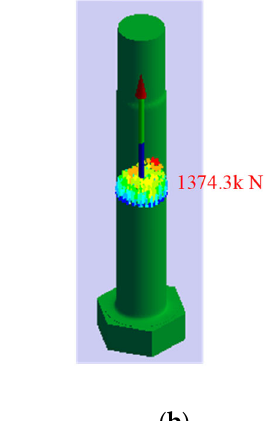
Figure 13. Resultant force of bolt: ( a ) existing configuration and ( b ) new design.